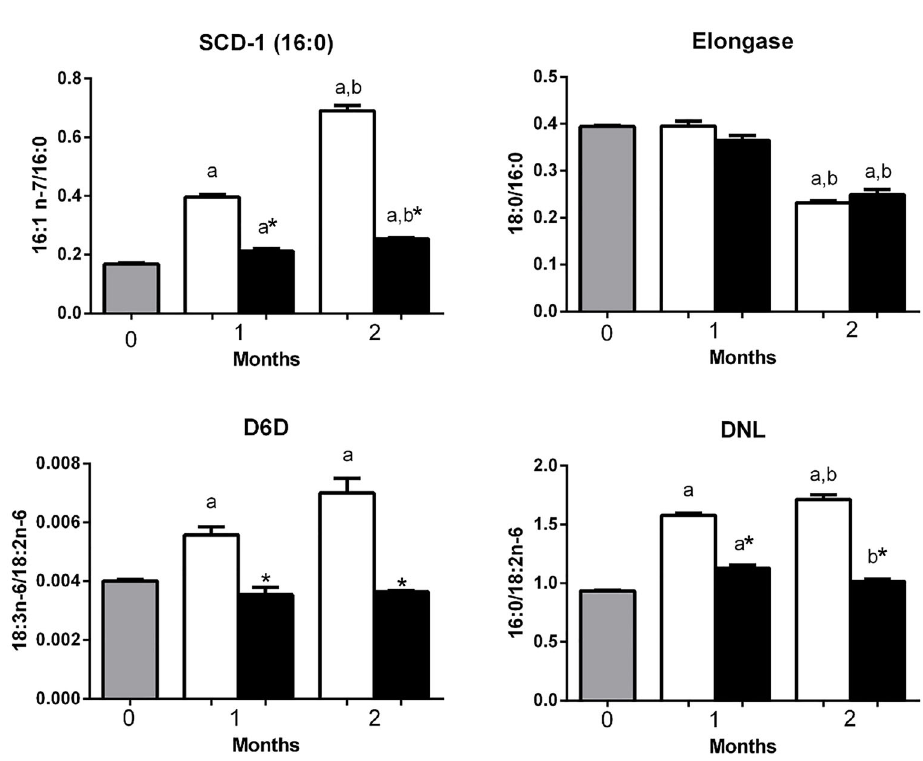
Figure 7. Activities of SCD-1, D6D, elongase 6, and de novo lipogenesis (DNL) in the gastrocnemius muscle from mice at 0 (before starting the diets, gray bars) or fed with a high-carbohydrate diet (HCD, white bars) or high-fat diet (HFD, black bars) 1 or 2 months. Results are reported as means ± SE. *P o 0.05 compared to HCD group (Student ’ s t -test). a P o 0.05 compared to time 0; b P o 0.05 compared to 1 month (one-way ANOVA). SCD-1: stearoyl-CoA desaturase-1; D -6 desaturase (D6D), DNL: de novo lipogenesis.